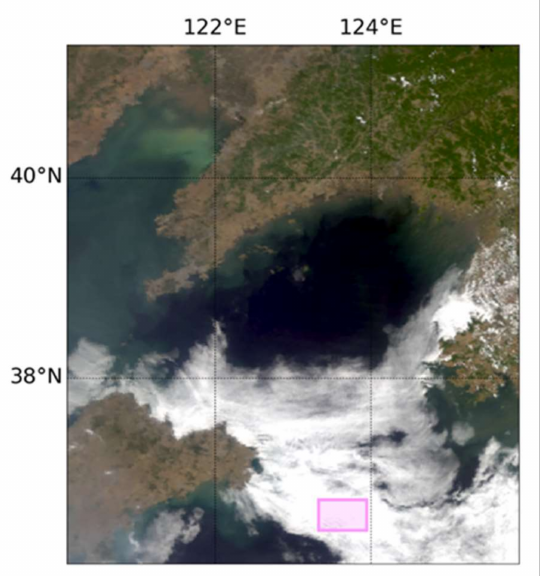
Figure 2. MODIS RGB image on 1 June 2017, 02:15 UTC and the selection of clouds. The pink box indicates